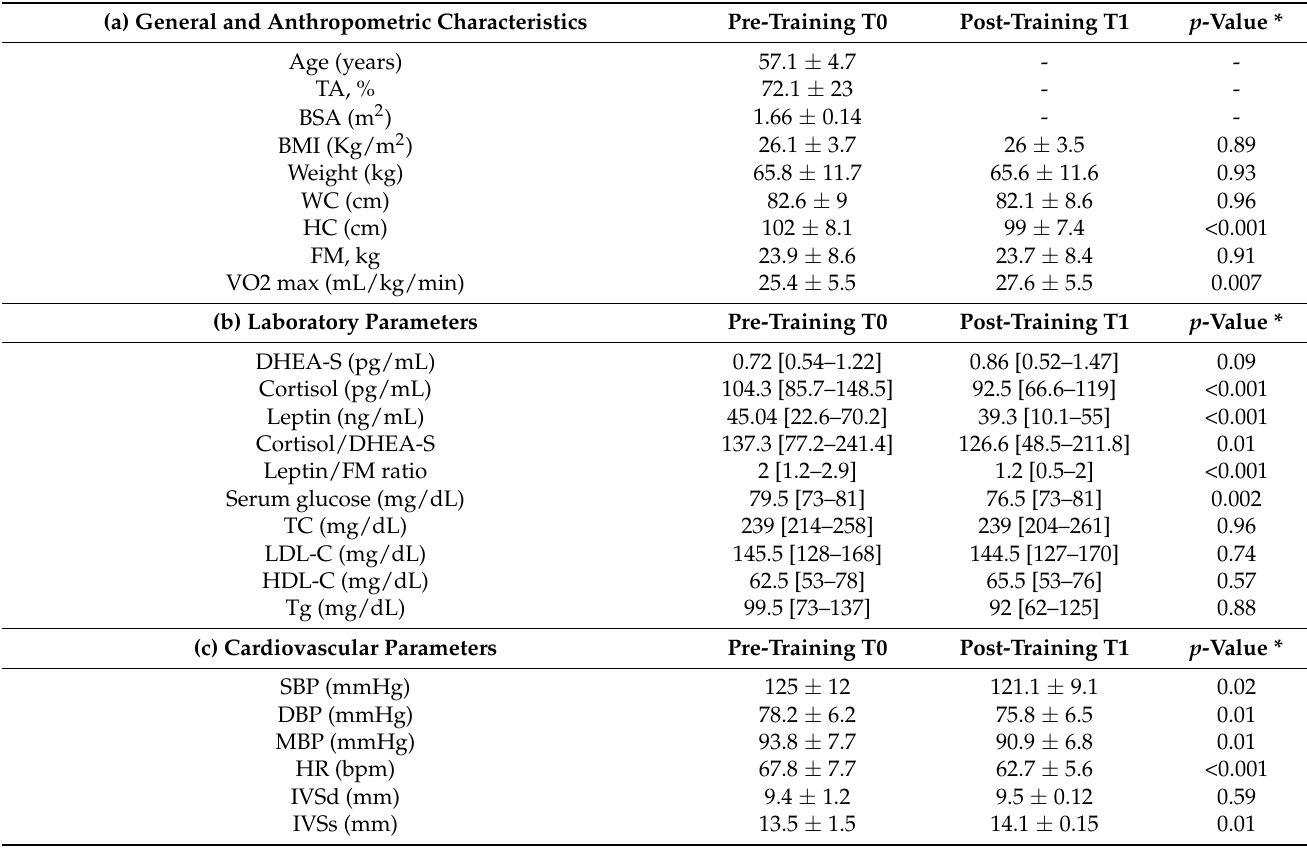
Table 1. Basal characteristics (pre-training, T0) and post-training (T1) cardiometabolic profile ( n = 43). (a) General and Anthropometric